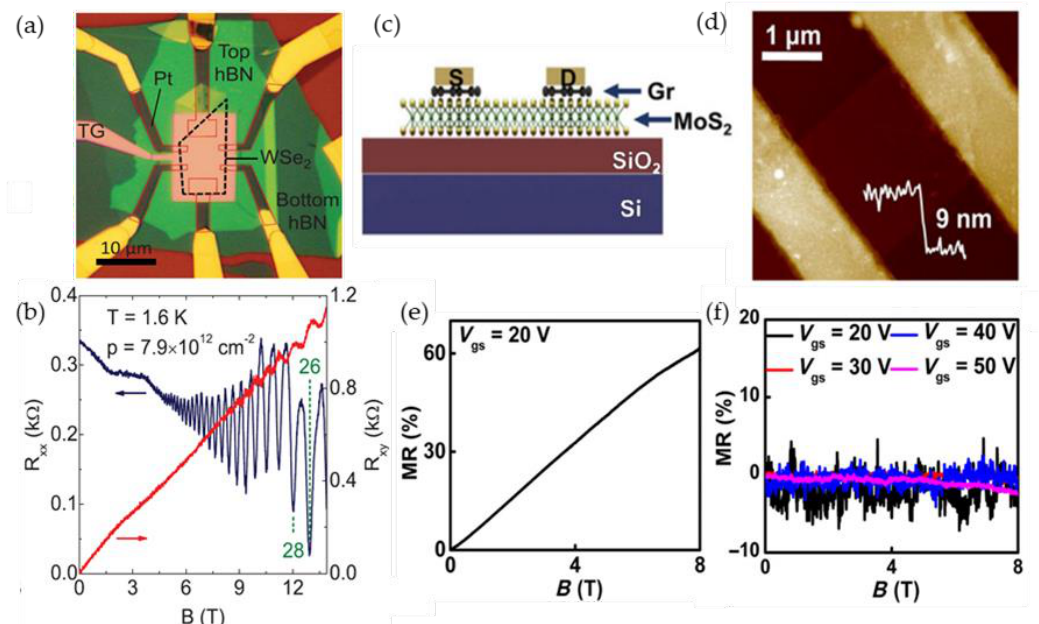
Figure 20. ( a ) Encapsulated monolayer WSe 2 device; ( b ) Shubnikov–de Haas oscillations in the longitudinal ( R xx ) and Hall ( R xy ) resistances of WSe 2 device measured as a function of the magnetic field at a temperature of 1.6 K. SdHO appear in R xx starting at magnetic field of ~4.5 T. The steps appearing in R xy , indicate the quantum Hall states. Reprinted from [146]. Copyright © 2016, American Physical Society; ( c ) the cross-sectional view of the MoS 2 FET; ( d ) the AFM image of the MoS 2 FET; ( e ) the magnetoresistance dependence of MoS 2 FET on magnetic field at constant gate voltage V gs at 2K; and ( f ) the MR of pure MoS 2 FET without graphene insertion. Reprinted from [147]. Copyright © 2020, Tsinghua University Press and Springer-Verlag GmbH Germany, part of Springer Nature.